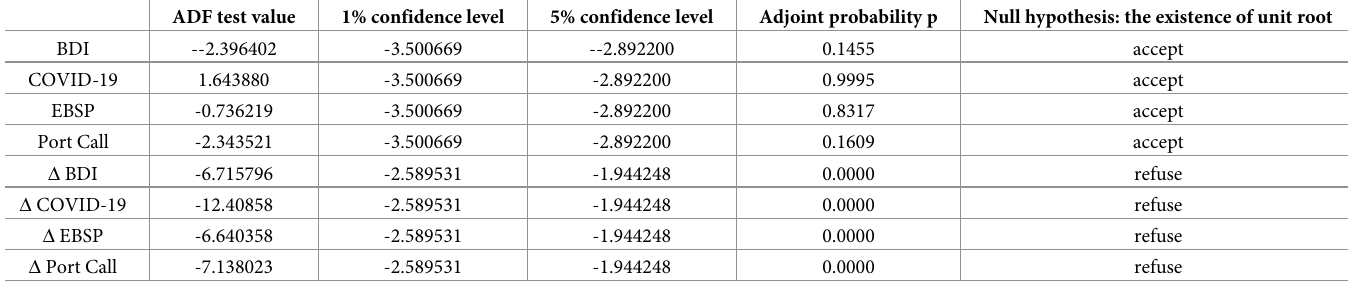
Table 1. Results of ADF test for